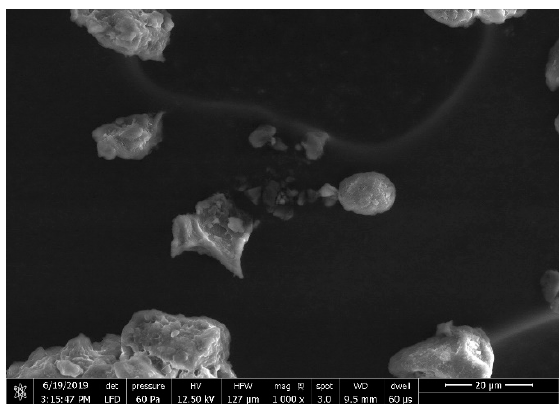
Figure 2. Morphology SEM of Arabica coffee ground nanoparticles.